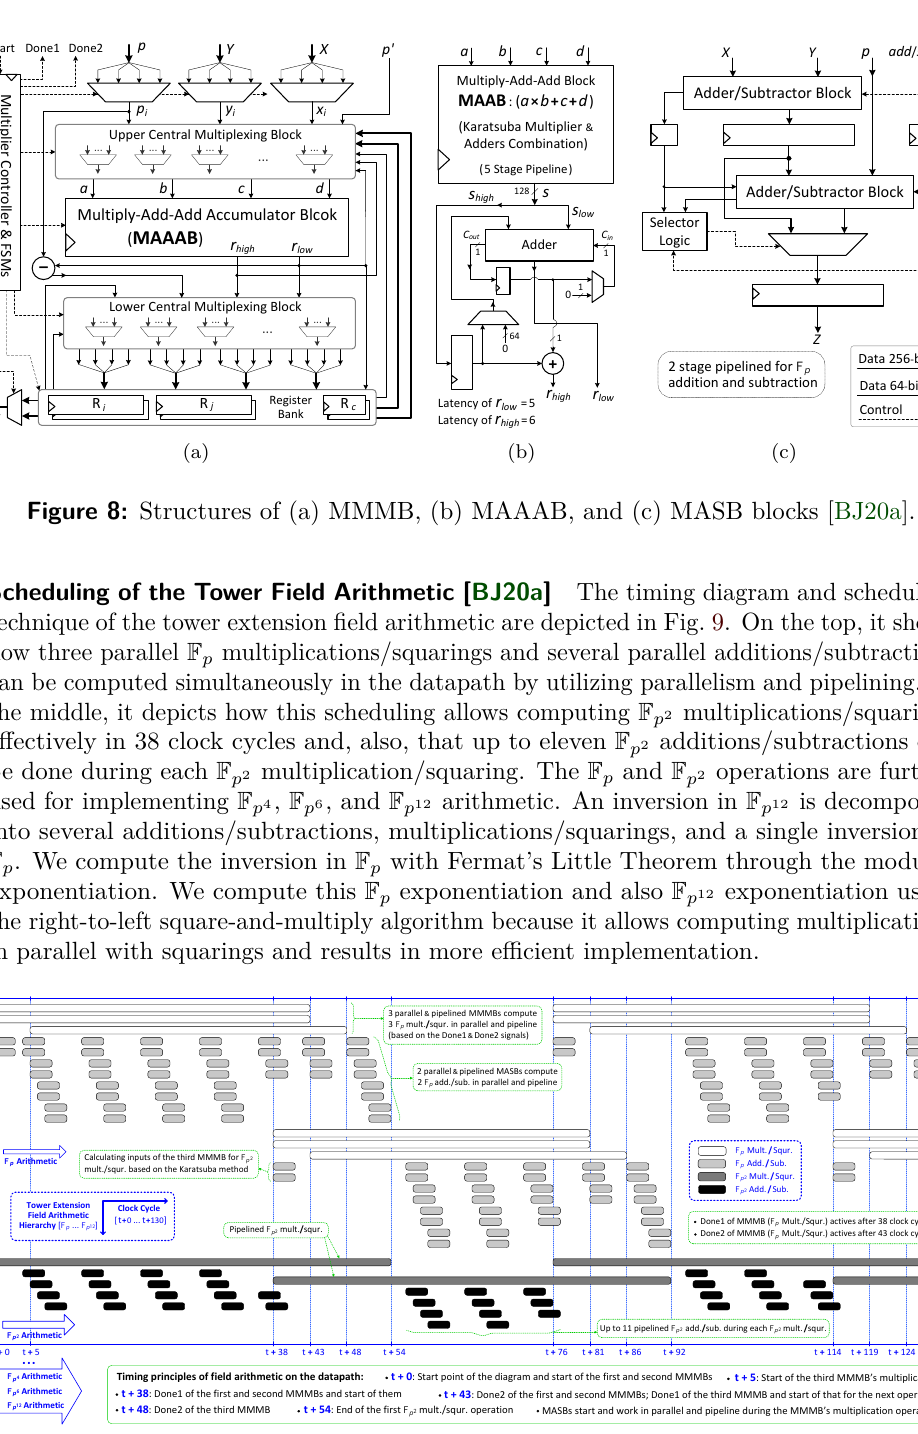
, F , F , F , and F arithmetic) in our datapath p p 2 p 4 p 6 p 12